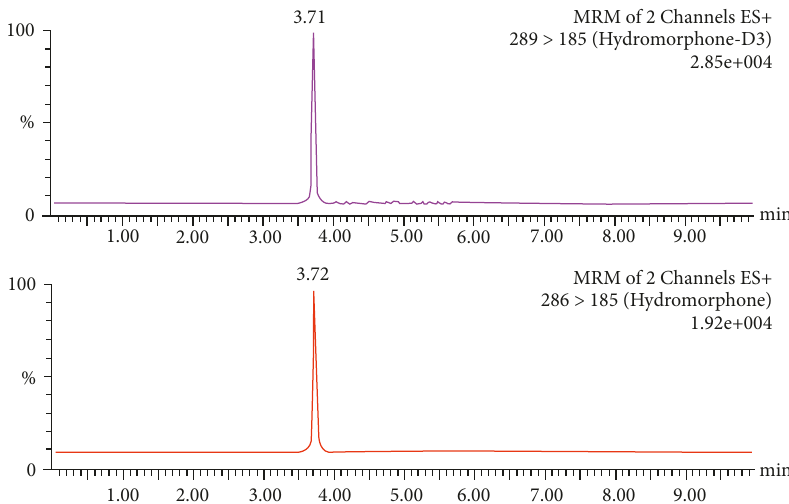
Figure 2: Chromatogram of a control sample (blank plasma plus standard plus internal standard) with a concentration of 2.5 ng/mL. The internal standard hydromorphone-D3 is presented in the upper panel and hydromorphone in the lower panel,